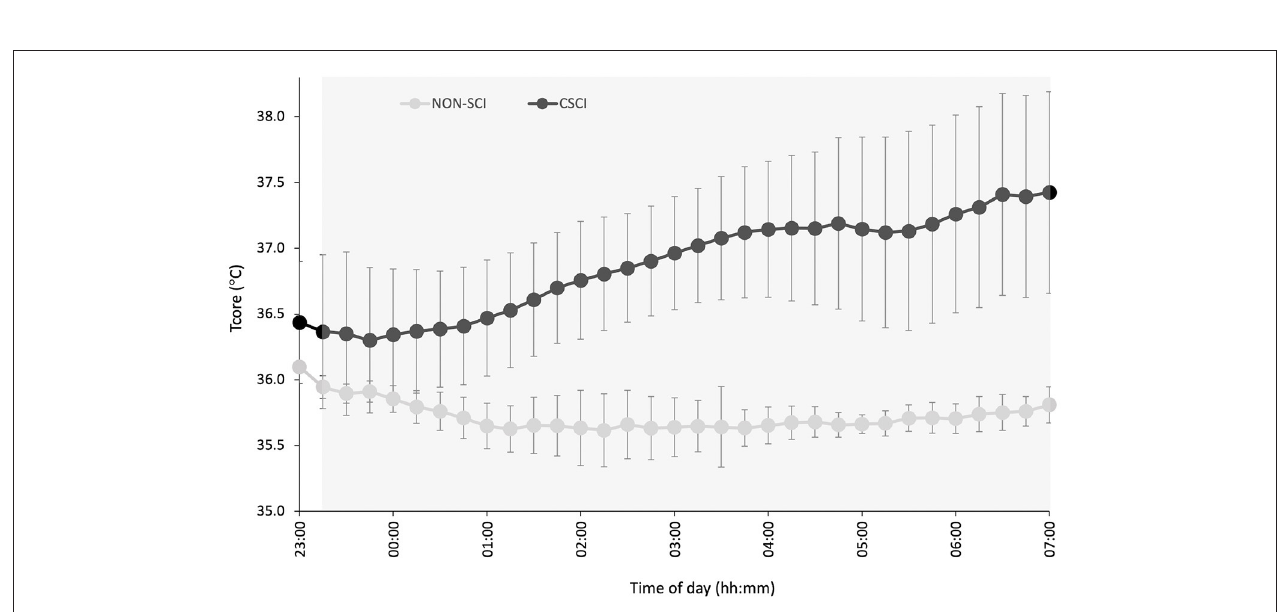
FIGURE 4 | Night-time T core in participants with a cervical spinal cord injury (CSCI; n = 3) and without a spinal cord injury (NON-SCI; n = 4). The gray region represents the average time of sleep for all subjects. Data are presented as a mean over a 15min period, whereas error bars represent SE.